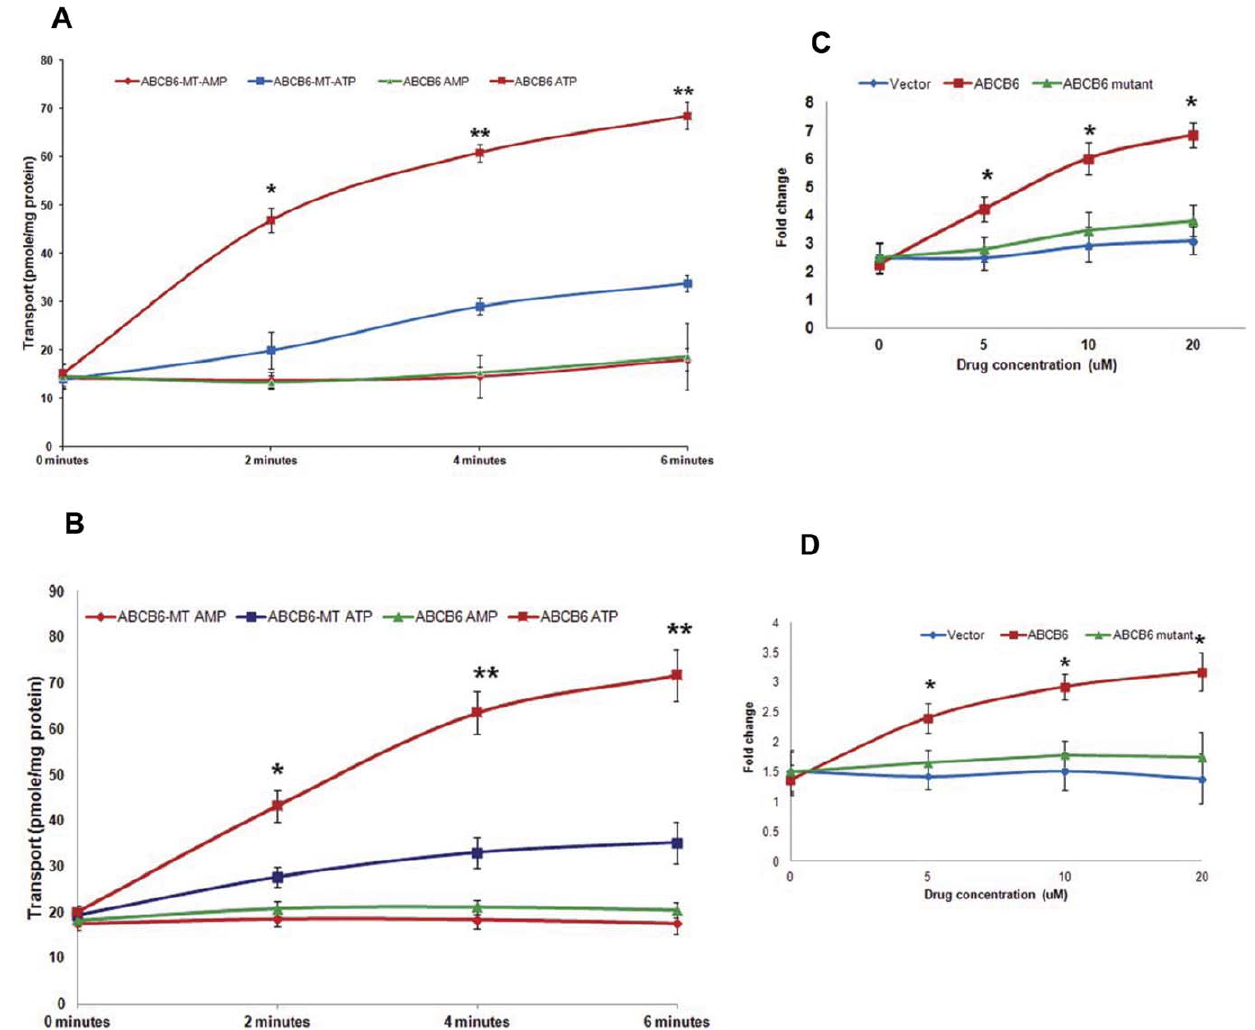
Figure 8. Verteporfin and tomatine hydrochloride are ABCB6 transport substrates. (a) verteporfin and (b) tomatine hydrochloride are transported by transport competent ABCB6 protein (ABCB6) in the presence of ATP which is significantly higher than transport by transport incompetent ABCB6 protein (ABCB6-MT) in the presence of ATP in mitochondria isolated from ABCB6 or ABCB6-MToverexpressing cells. Results are representative of three independent experiments. ‘*’ significantly different from ABCB6-MT and AMP treated ABCB6 expressing mitochondria; P , 0.05. ‘**’ significantly different from ABCB6-MT and AMP treated ABCB6 expressing mitochondria; P , 0.01. (c) and (d) vanadate sensitive ATPase activity (fold change relative to basal activity) was stimulated by (c) verteporfin and (d) tomatine hydrochloride in mitochondria from cells expressing transport competent ABCB6 protein (ABCB6) relative to mitochondria isolated from transport incompetent ABCB6 protein (ABCB6-MT). Values are means + / 2 SEM. ‘*’ significantly different from ABCB6-MT cells at each time point; P ,